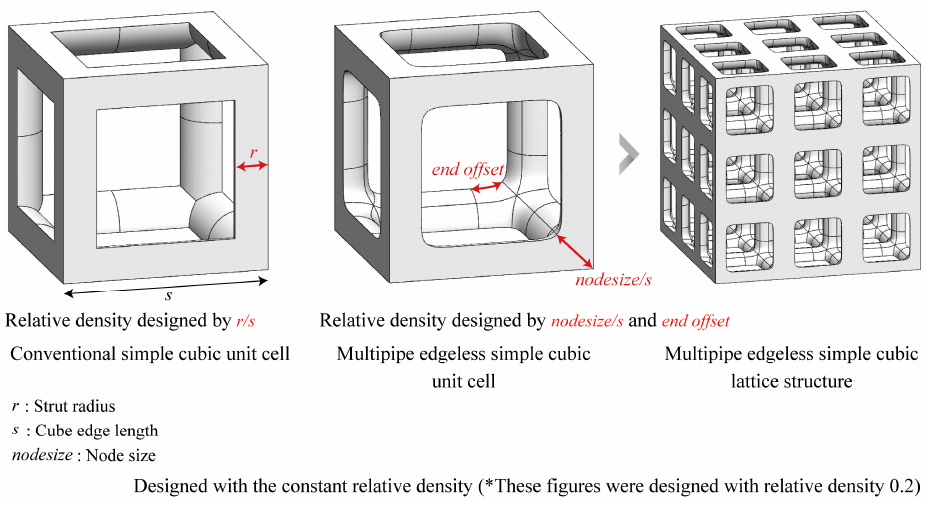
Figure 10. Schematics of the multipipe edgeless simple cubic lattice structure. The structures were designed with a constant relative density of 0.2.